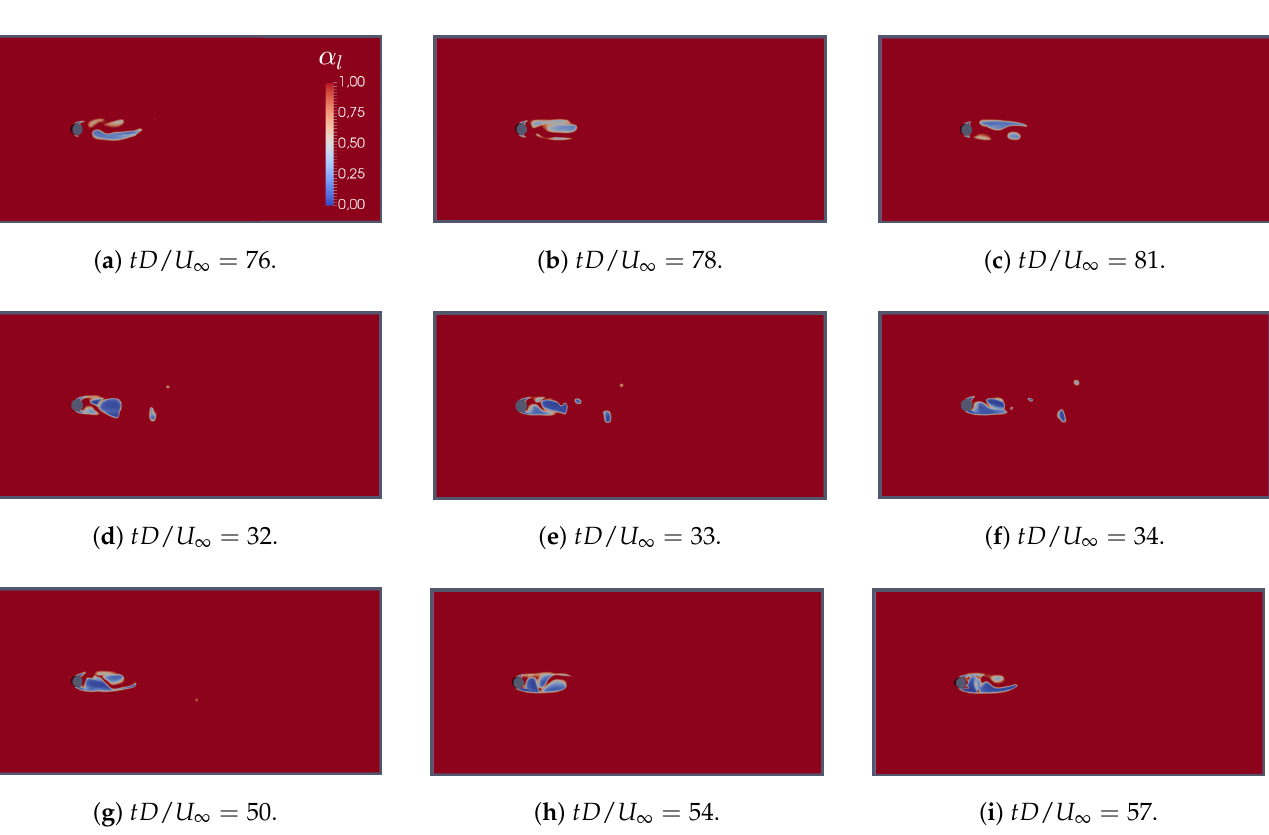
Figure 7. Contour plot of instantaneous liquid fraction, results obtained with Saito model and considering standard coefficients.